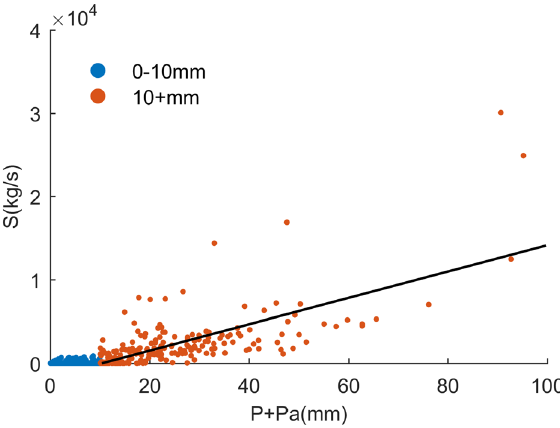
Figure 4. Relationship of rainfall ( P + P a ) to sediment ( S ).